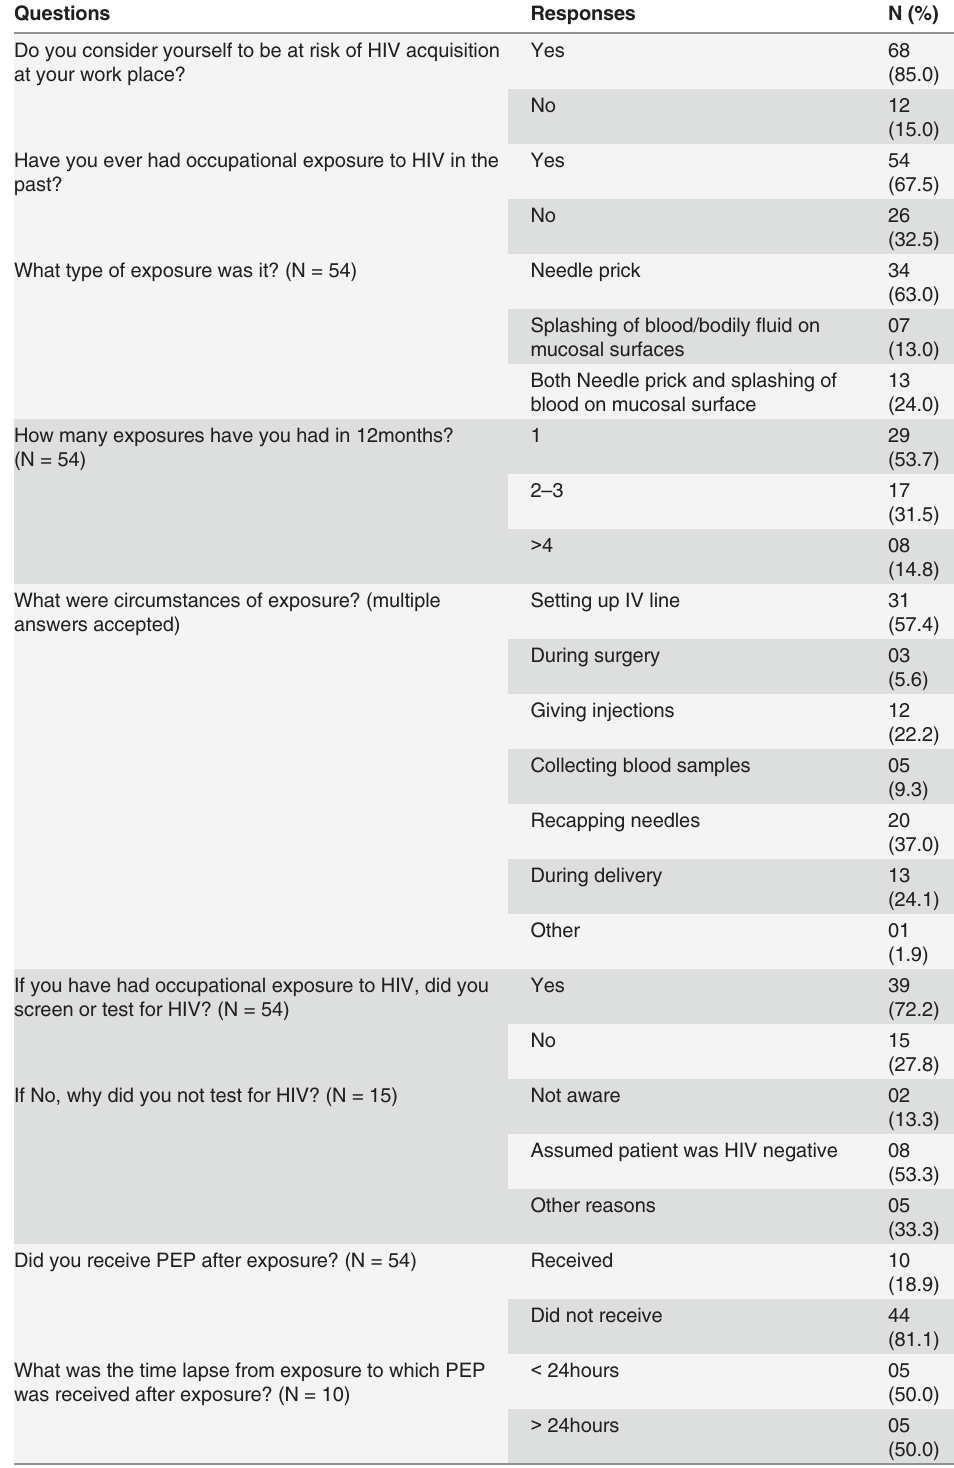
Table 4. Risks, Exposures and Practices of PEP for HIV among Nurses in Tubah Health District,